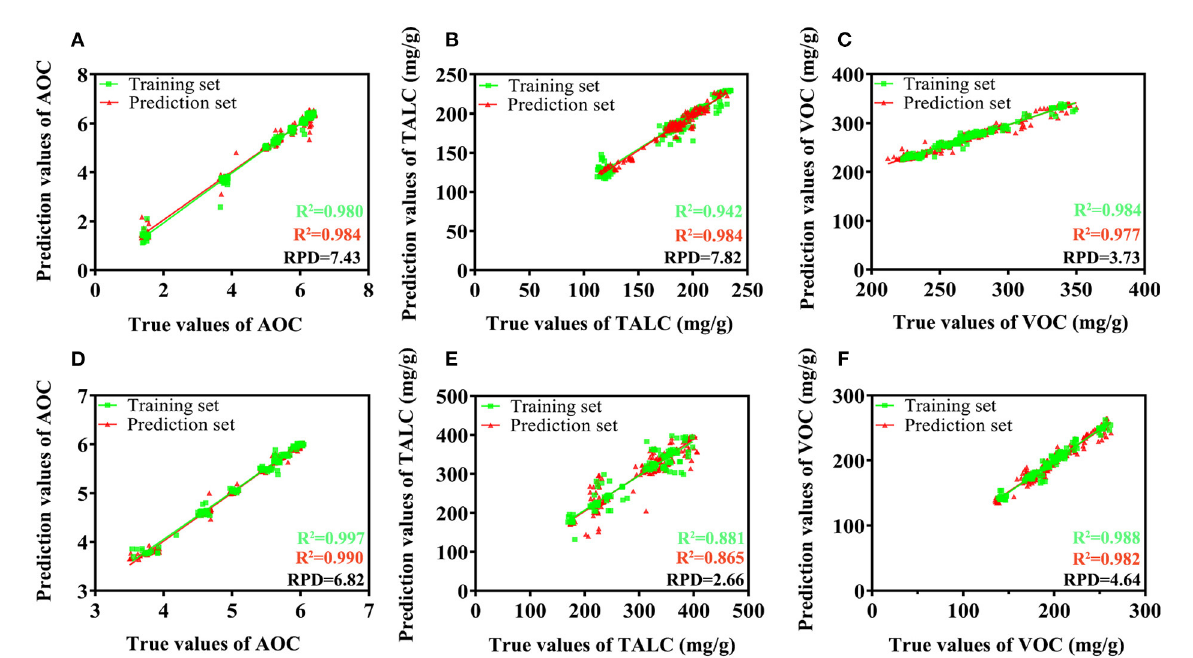
FIGURE2 The most suitable models for chemical indicators prediction of HJ samples. (A) : AOC prediction of RHJ (MASS-WT-PLSR), (B) : TALC prediction of RHJ (IVSO-WT-BPNN), (C) : VOC prediction of RHJ (WT-RF based on the full wavelengths), (D) : AOC prediction of GHJ (MASS-WT-RF), (E) : TALC prediction of GHJ (IVSO-WT-PLSR), (F) : VOC prediction of GHJ (WT-RF based on the full wavelengths).